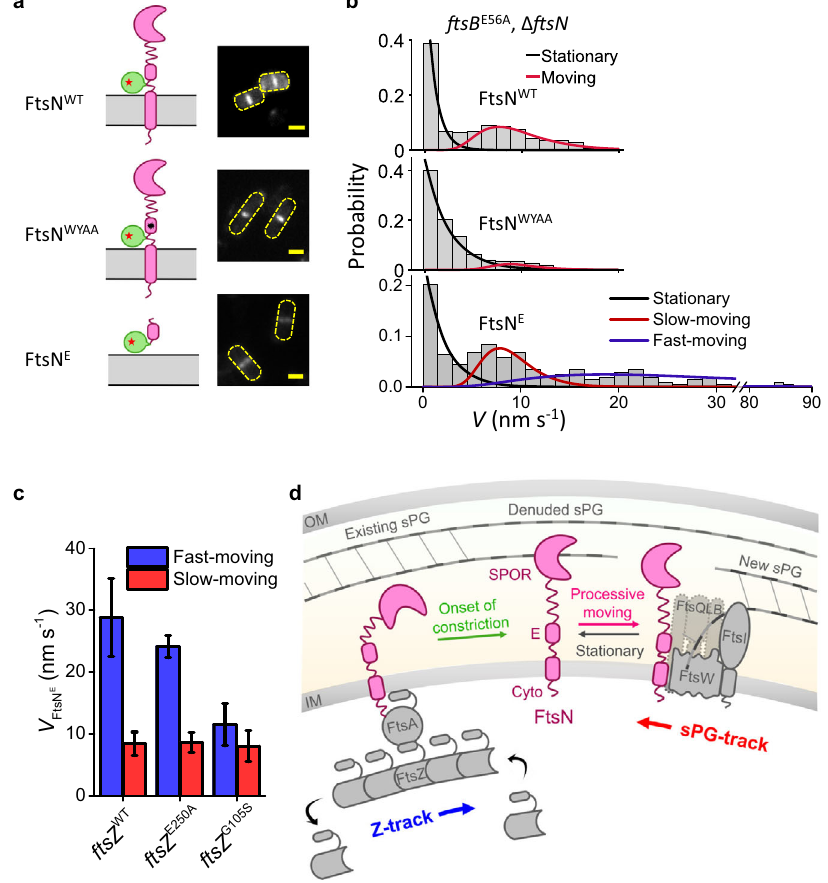
Fig.4|FtsN ’ sEdomainissuf fi cienttoformaprocessivecomplexwithFtsWIon the sPG-track. a Schematic representation of FtsN-Halo SW , FtsN WYAA -Halo SW , and Halo-FtsN E fusions(left,blackstarinFtsN WYAA -Halo SW representstheW83AandY85A doublesubstitution) and the corresponding representative ensemble fl uorescence images (right, all expressed in the super fi ssion variant ftsB E56A Δ ftsN background). Scale bars, 1 µ m. Similar images were observed in n >50 cells for each mutant. b Speed distributions and corresponding fi t curves for stationary (black), slow- moving (red) and fast-moving (blue) populations of single FtsN-Halo SW , FtsN WYAA - Halo SW , and Halo-FtsN E molecules (top to bottom). The x -axis breaks from 32 to 79nms − 1 . c Decomposed mean speed of the fast-moving population of Halo-FtsN E (blue bars) is correlated with FtsZ ’ s GTPase activity, while the speed of the slow- moving population of Halo-FtsN E (red bars) is independent of FtsZ ’ s GTPase activity. Data are presented asmean ± s.e.m. and listed in Supplementary Table 12. Source data are provided as a Source Data fi le. d A model depicting how FtsN